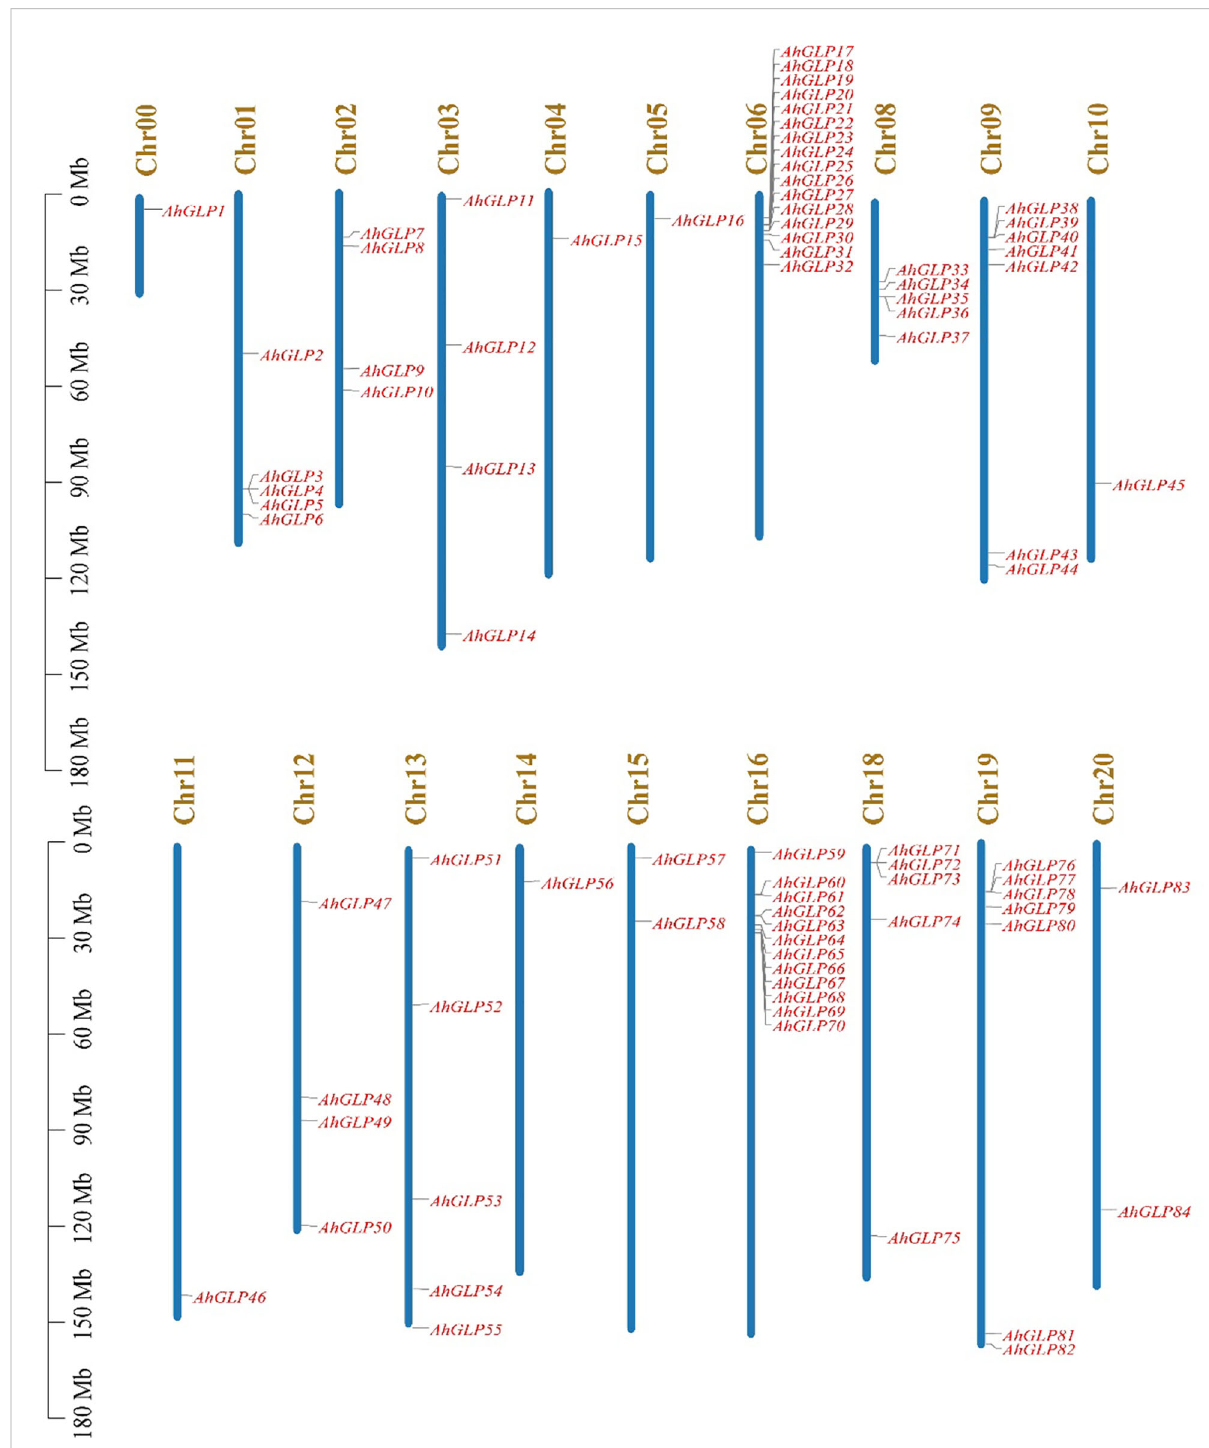
FIGURE 1 Chromosomal distribution of Arachis hypogaea Germin-like protein ( AhGLPs ) genes. The scale on left side indicates the chromosome